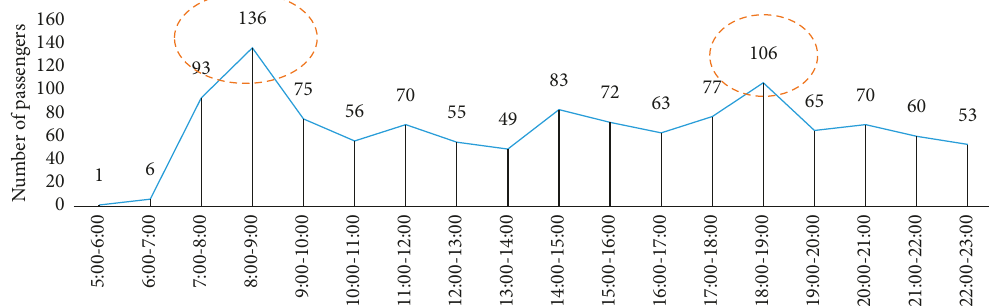
Figure 10: Passenger flow distribution of one workday in September 2021.